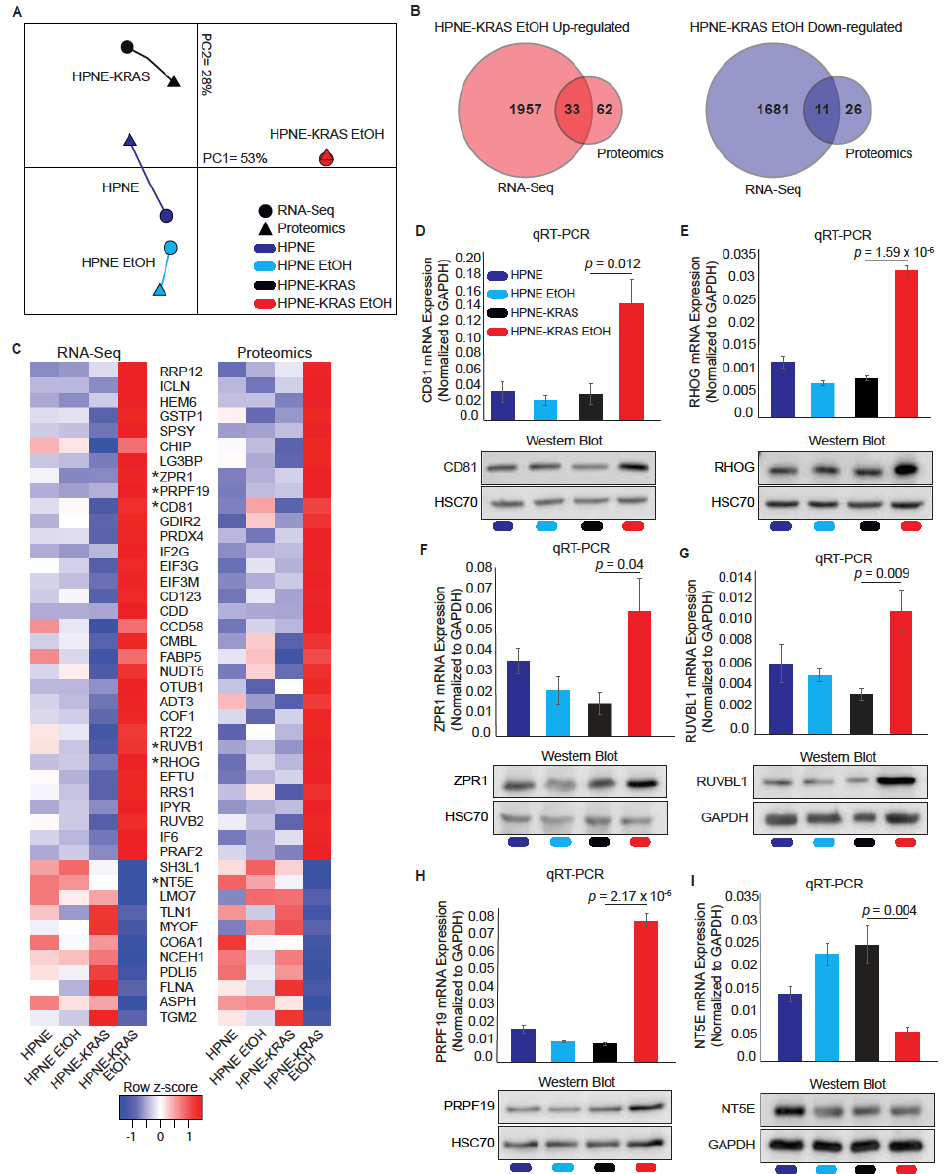
Figure 5. Mutant KRAS cells treated with ethanol display a higher level of transcriptional and translational coordination. ( A ) Multiple Co-inertia analysis of RNA-Seq and proteomics data. Length of the line connecting the proteomics and RNA-Seq data represents their dissimilarity; RNA-Seq n = 1, proteomics n = 3. ( B ) Venn diagrams showing differentially expressed protein coding genes (RNA-Seq, ±2-fold change) and proteins (Proteomics, ±1.25-fold change) common in the RNA-Seq and proteomics data. ( C ) Heatmaps of all conditions showing expression of commonly detected up-(33) and down-(11) regulated protein-coding transcripts (left) and proteins (right) found in HPNE-KRAS EtOH cells compared to HPNE-KRAS cells. ( D – I ). Validation of omics data by qRT-PCR and Western blot for CD81 ( D ), RHOG ( E ), ZPR1 ( F ), RUVBL1 ( G ), PRPF19 ( H ), and NT5E ( I ); indicated in ( C ) by *. The qRT-PCR was performed to validate RNA-Seq expression with GAPDH used for normalization. Mean ± SEM; n = 4. Western blots were used to validate proteomics expression using HSC70 or GAPDH as loading control. Cluster of Differentiation 81 (CD81); Ras Homolog Family Member G (RHOG); ZPR1 zinc finger (ZPR1); RuvB like AAA ATPase 1 (RUVBL1); Pre-MRNA Processing Factor 19 (PRPF19); 5′ -Nucleotidase (NT5E). The original blots of Figure 5 could be found in Figure S5.